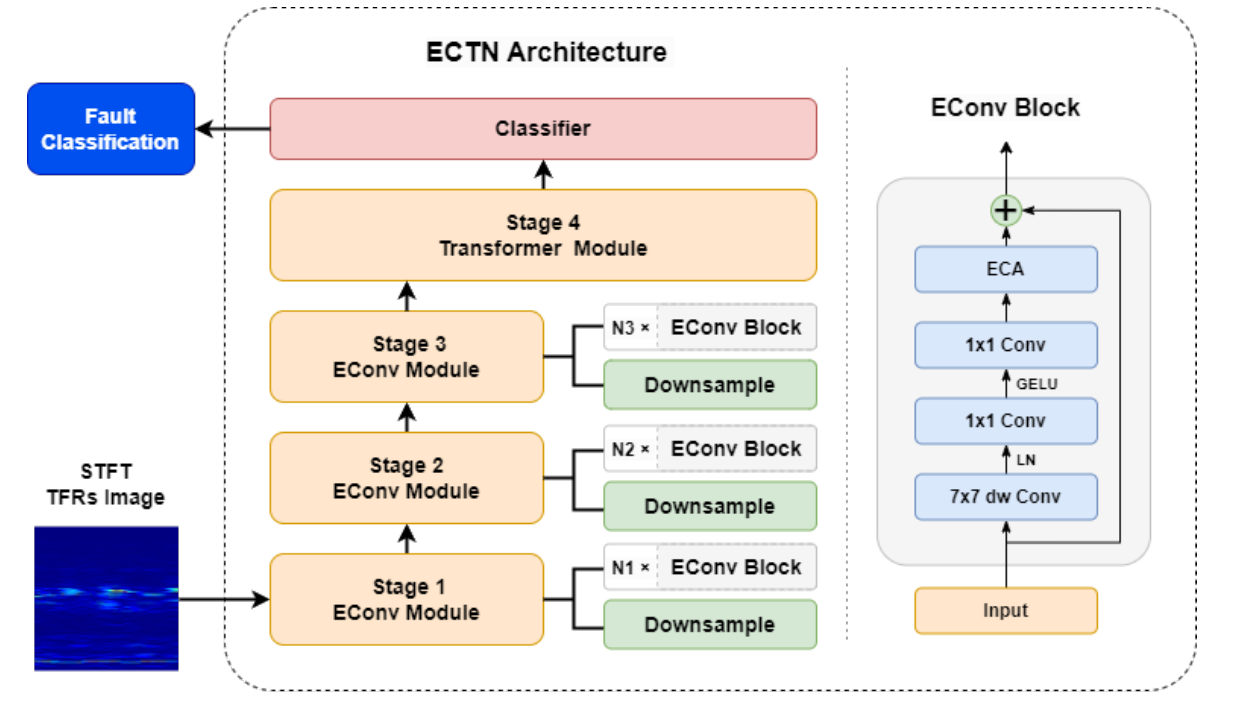
Figure 1. The proposed architecture of ECTN. Table 1. Details of the proposed